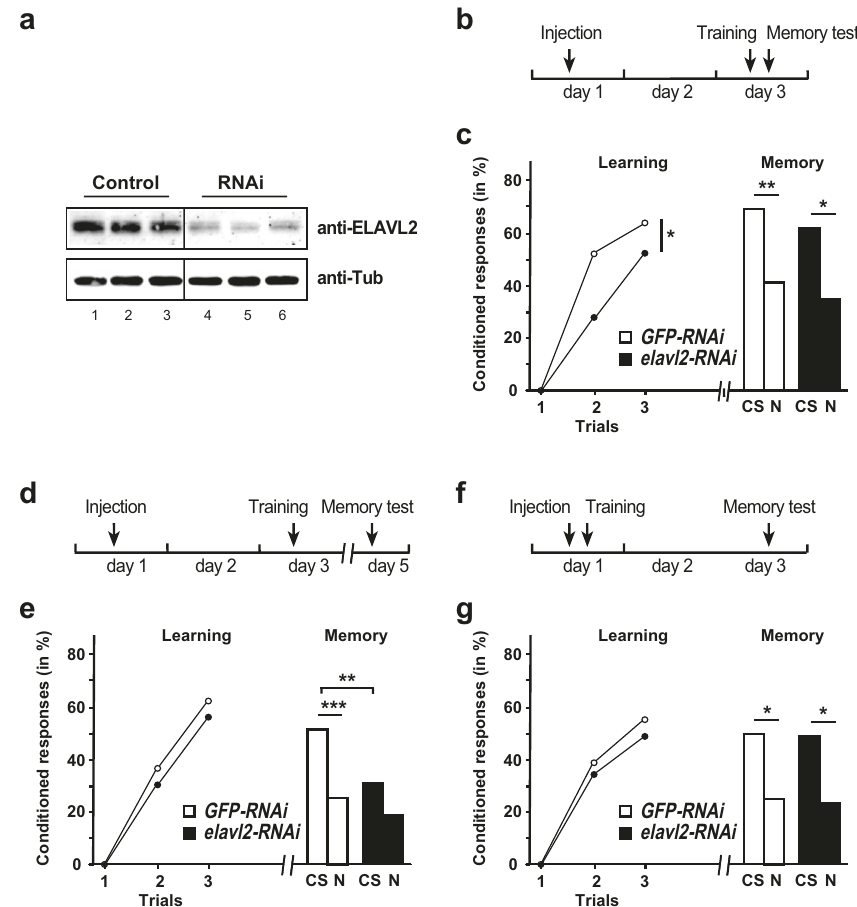
Fig. 1 ELAVL2 is required for learning and memory consolidation. a Western blot detecting ELAVL2 (top) or tubulin (bottom) in bee central brains of control GFP and elavl2 dsRNA-injected workers 50 h after injection. b Schematic of the treatment to test for ELAVL2 ’ s role in learning. c Learning ( left ) and memory ( right ) performances of control GFP dsRNA ( white , n = 66) and elavl2 dsRNA ( black , n = 74) injected worker bees. CS : conditioned odor, N : novel odorant. * p < 0.05; ** p < 0.01. d Schematic of the treatment to test for ELAVL2 ’ s s role in memory consolidation. e Learning ( left ) and memory ( right ) performances of control GFP dsRNA ( white , n = 74) and elavl2 dsRNA ( black , n = 77) injected worker bees. CS : conditioned stimulus, N : novel odorant ** p < 0.01; *** p < 0.001. f Schematic of the treatment to test for ELAVL2 ’ s role in memory retrieval. g Learning ( left ) and memory ( right ) performances of control GFP dsRNA ( white , n = 53) and elavl2 dsRNA ( black , n = 50) injected worker bees. CS : conditioned stimulus, N : novel odorant *: p < 0.05. The source data underlying this fi gure are available in Supplementary Data